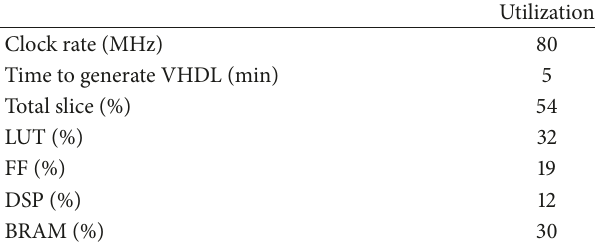
Figure18:ThroughputperformanceofType-IandType-IIschemes. Table 9: Performance and resource utilization, after mapping onto the FPGA, for the HARQ system (that supports both Type-I and Type-II mode of operation) on the NI USRP-2953R containing the Xilinx Kintex-7 (410t)